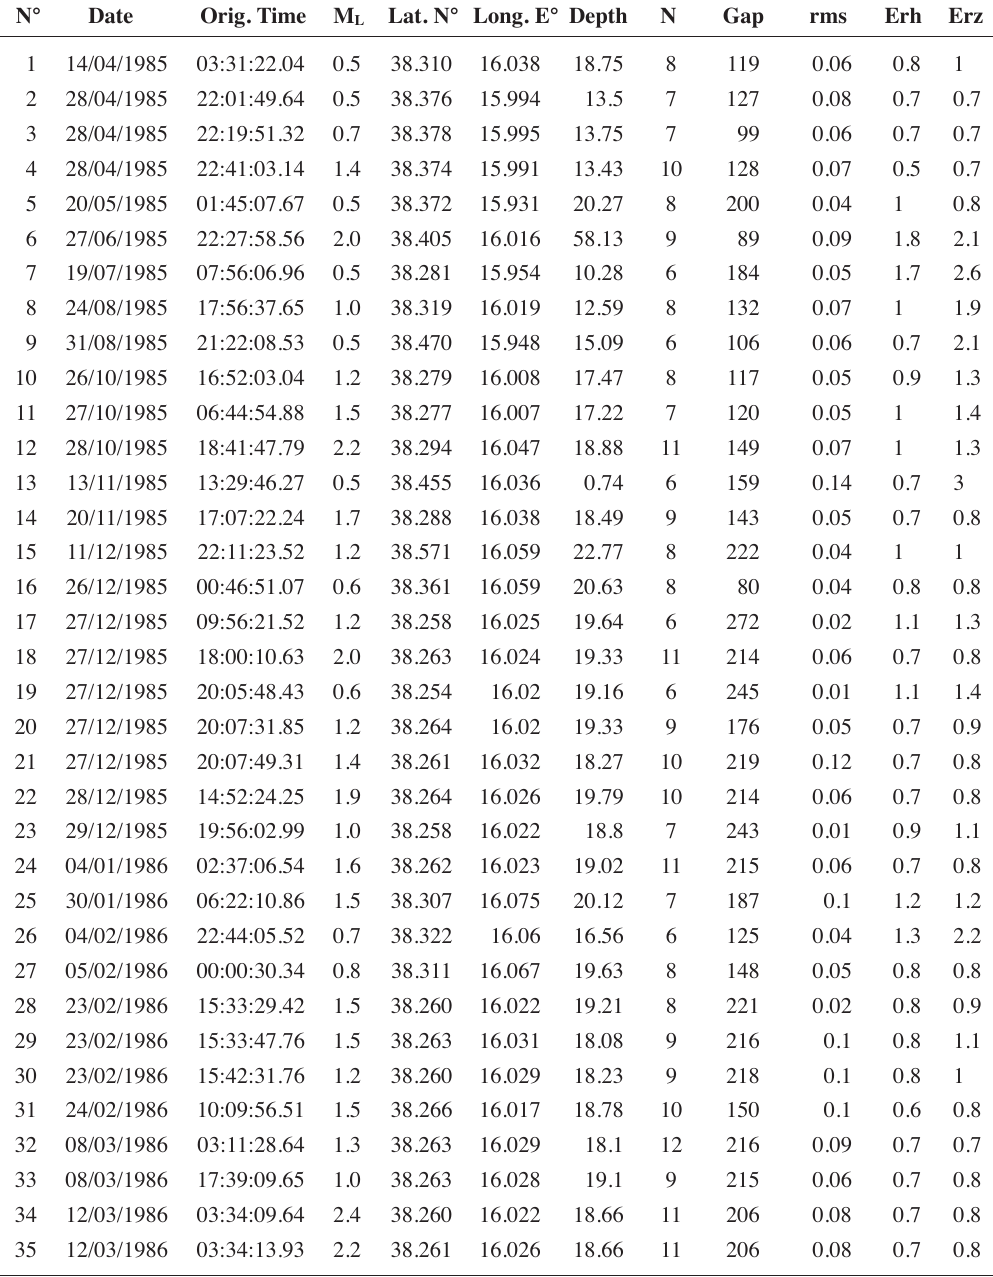
Table I. Location parameters of the 252 events selected from the ISMES catalogue, including local magnitude (M L ), number of data (N), azimuthal gap (Gap), squared residual travel times (rms), Erh and Erz. N° Date Orig.